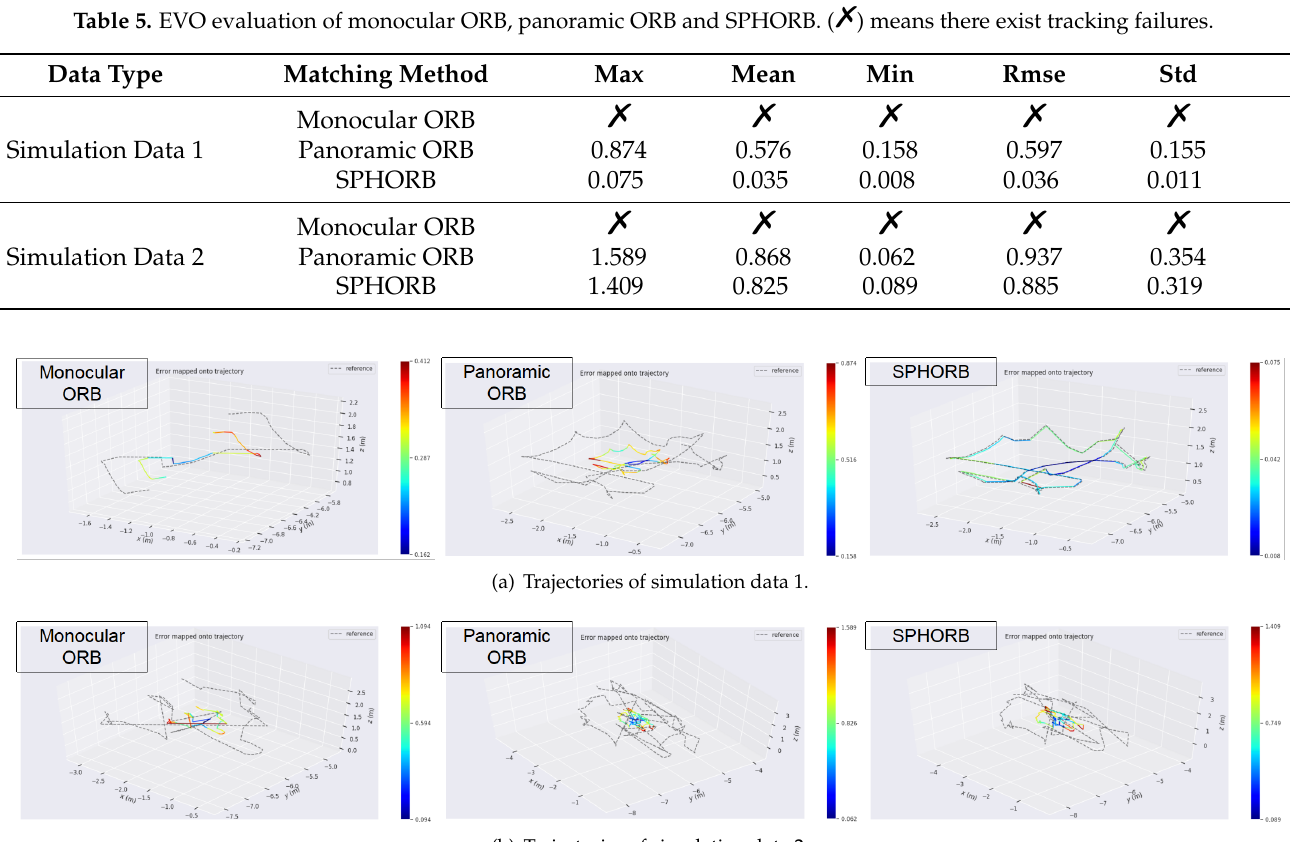
Figure 11. Trajectories drawn by